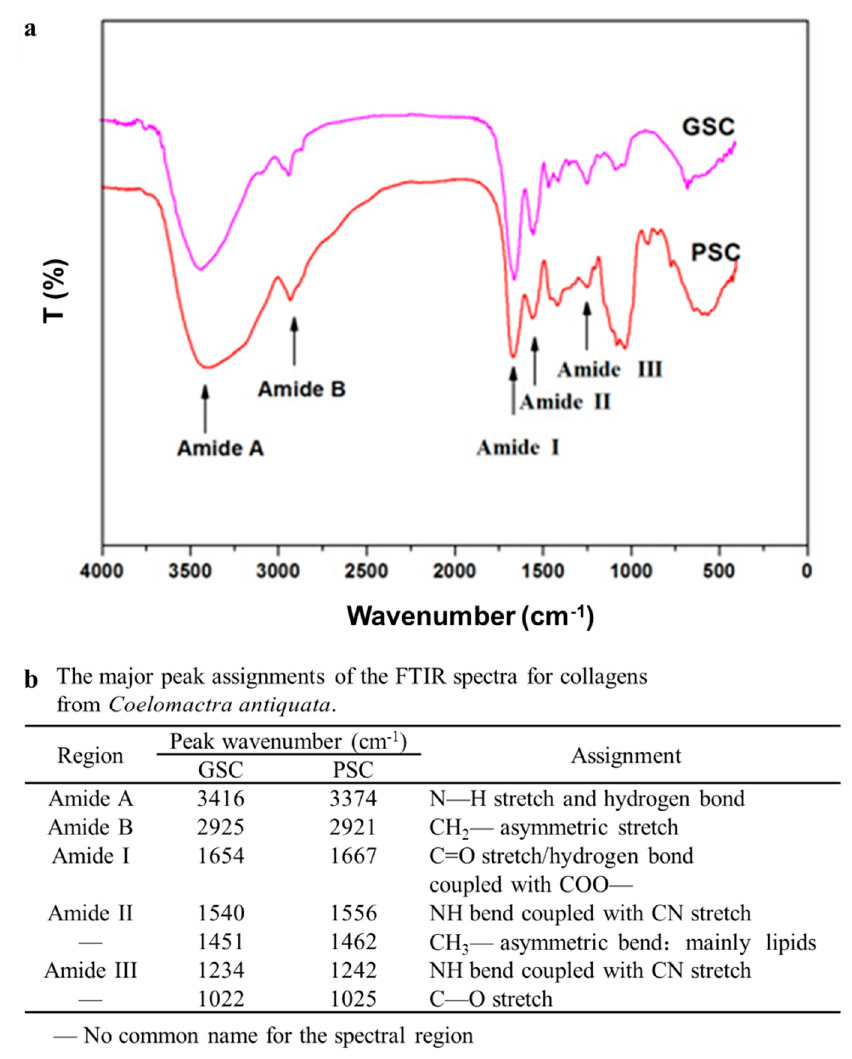
Figure 2. ( a ) Fourier transform infrared spectroscopy (FTIR) spectra of guanidine hydrochloride soluble collagen (GSC) and pepsin soluble collagen (PSC) from surf clam shell ( Coelomactra antiquata ); ( b ) The major peak assignments of the FTIR spectra for collagens from surf clam shell ( Coelomactra antiquata ).